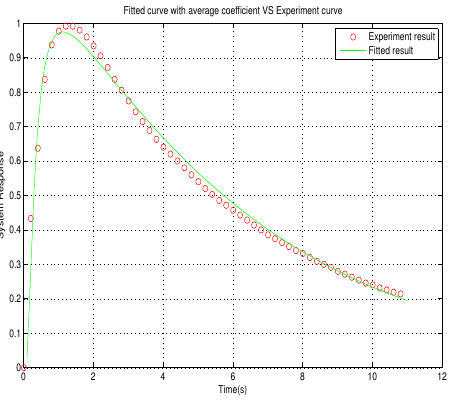
Fitted curve with average coefficient VS Experiment curve